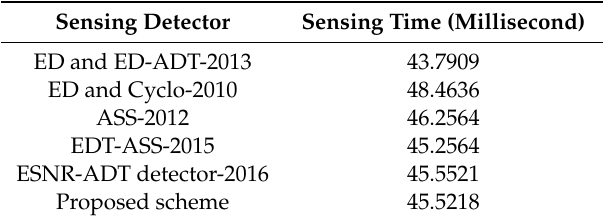
Table 4. Comparison of detectors concerning their sensing times.